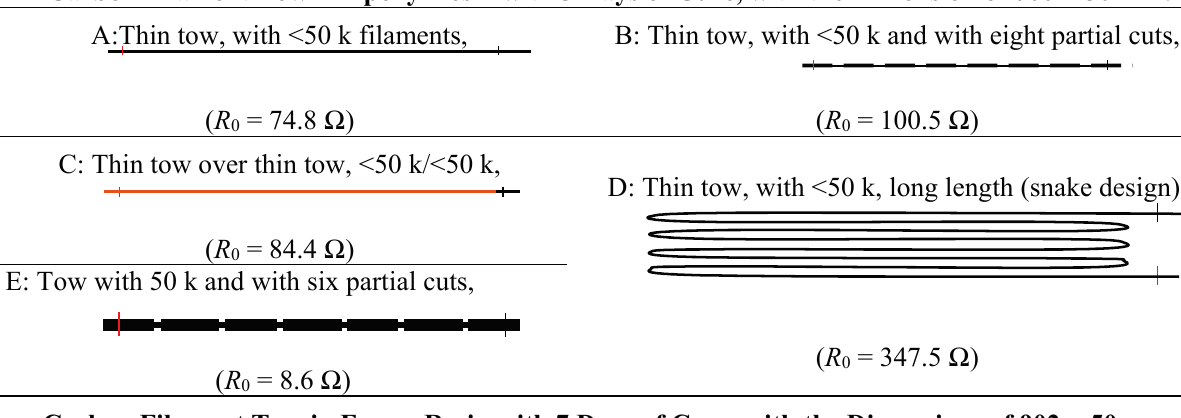
Table 2. General features of specimens for preliminary tests at the Dynamometer. Carbon Filament Tow in Epoxy-Resin with 3 Days of Cure, with the Dimension of 700 × 50